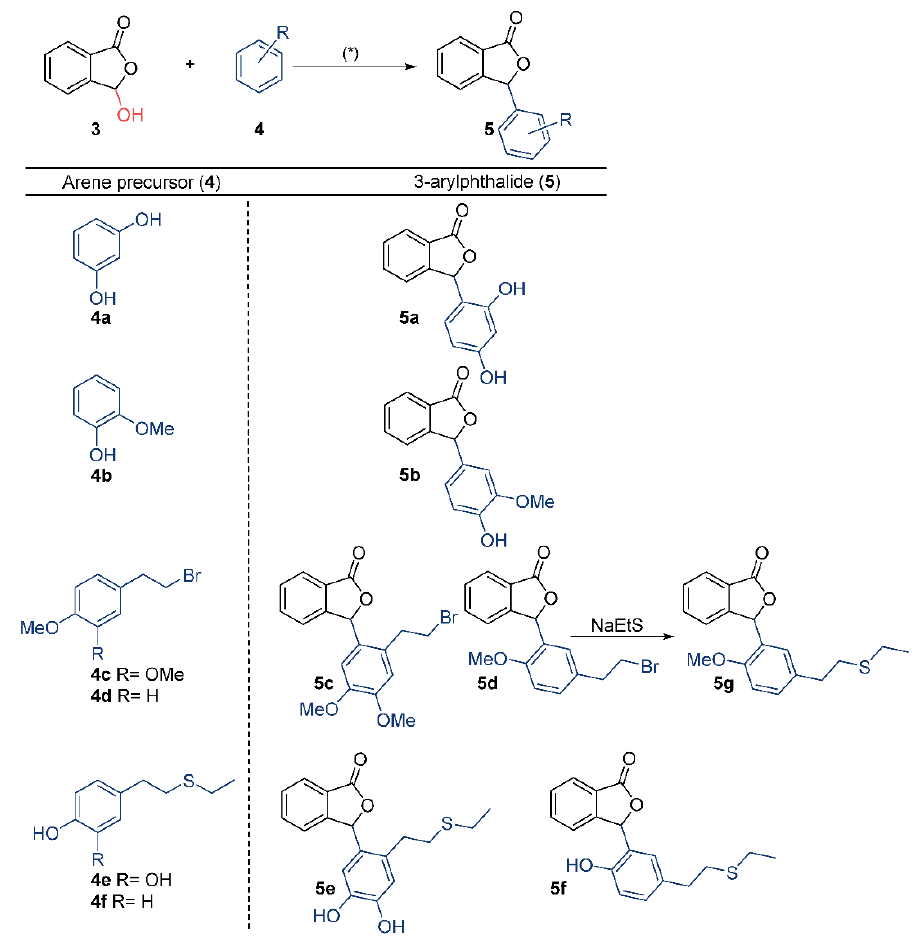
Figure 3. Synthesis of compounds 5a – 5g . (*) dioxane/H 2 O (1:4) + 5% HCl for 5a , H 2 SO 4 /H 2 O for 5b – 5f .